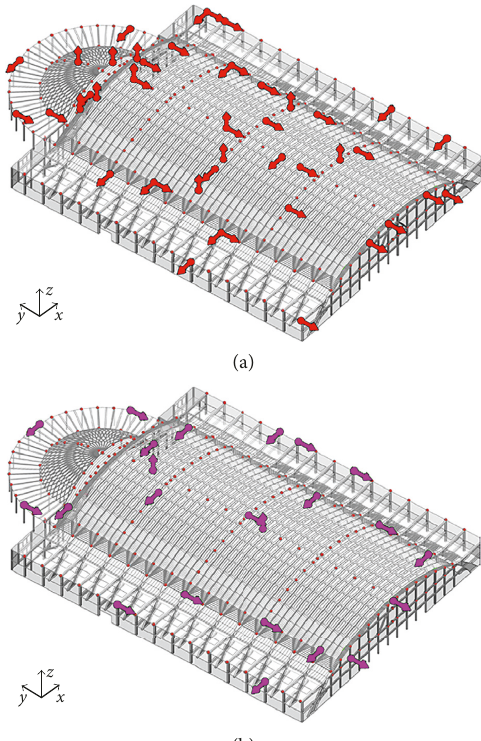
Figure 18: Sensor configuration layout: setup (a) shows the OSP for the undamaged structure and setup (b) represents the OSP for the damaged